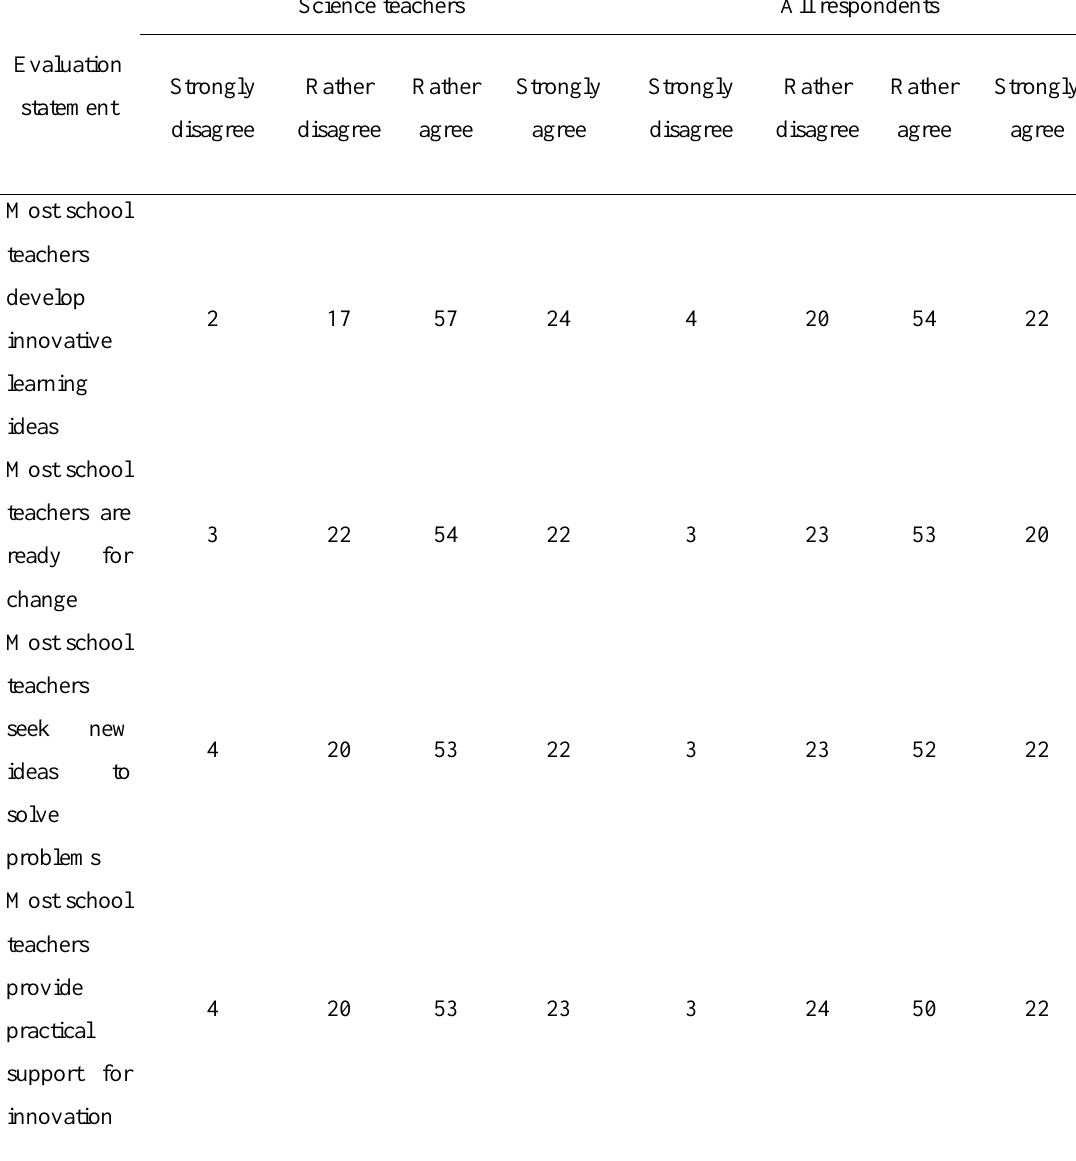
Table 3. School teachers’ attitude to innovation, %